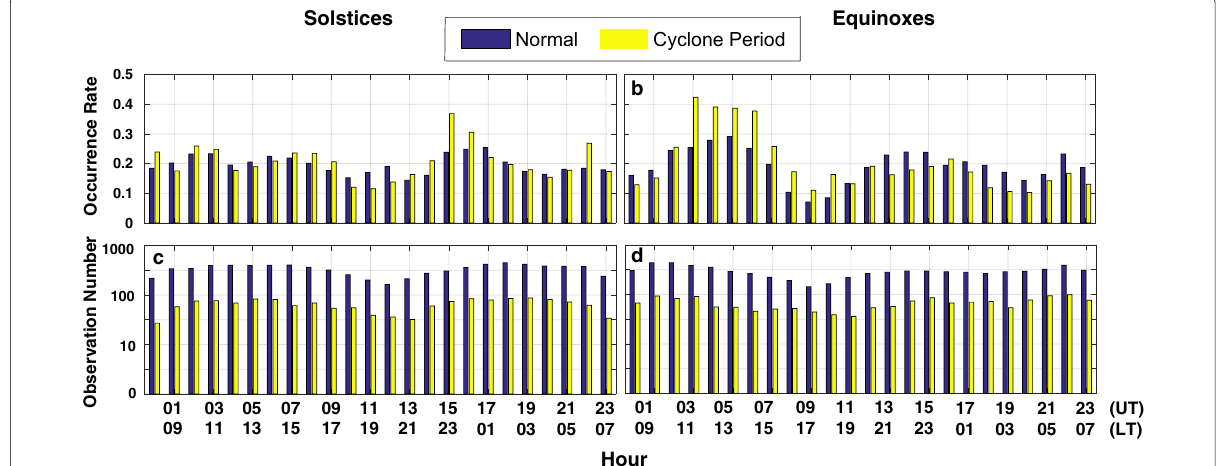
Fig. 8 LT variations in MSTID occurrence rates during solstices and equinoxes under different cyclone period conditions